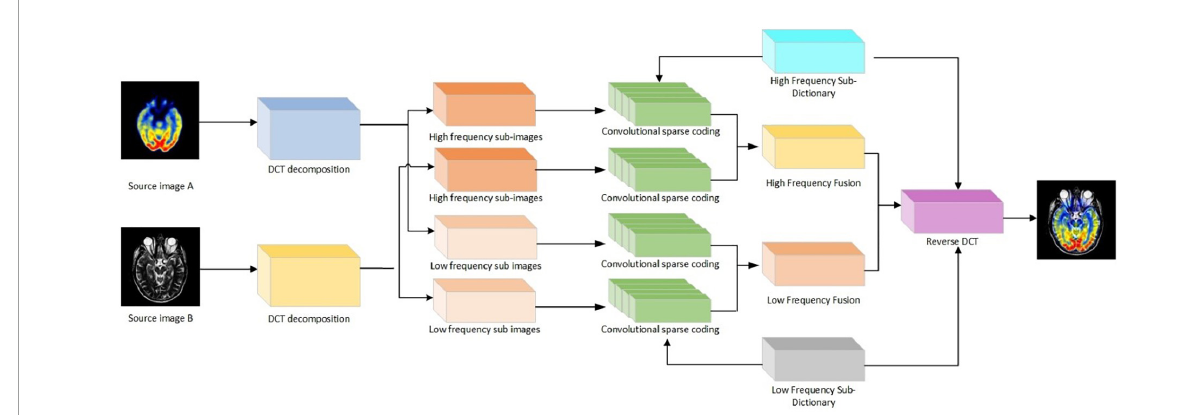
FIGURE1 Flowchart of image fusion algorithm for discrete cosine transform (DCT) transform.